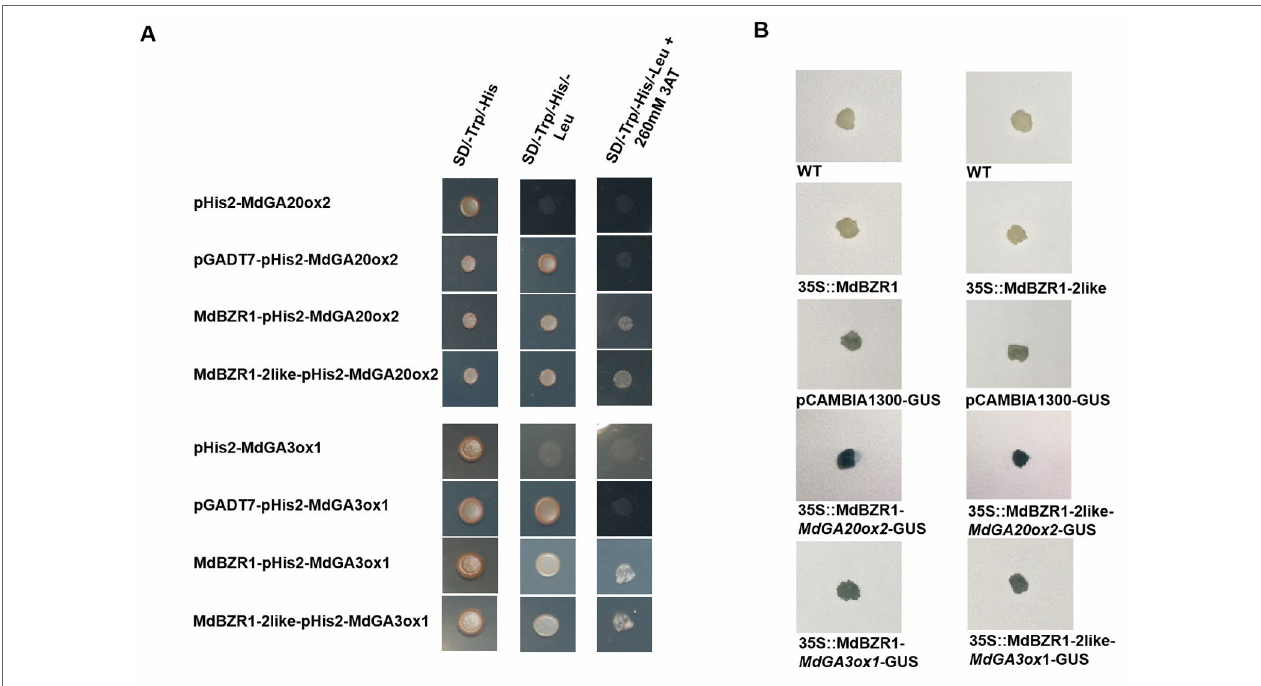
FIGURe 4 | Interactions between MdBZR1, MdBZR1-2like and the promoters of MdGA20ox2 and MdGA3ox1 in vivo . (A) Yeast One-Hybrid (Y1H) assay of the interaction between MdBZR1, MdBZR1-2like, and MdGA20ox2 and MdGA3ox1 promoters. The yeast strains were grown on SD/-Leu/-Trp and SD/-Leu/-Trp/-